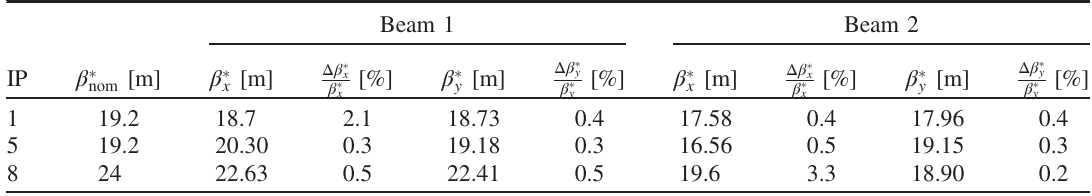
TABLE VII. Measured β (cid:1) and its associated error in IP1, IP5, and IP8 using K mod during the 2016 MD on vdM optics after introducing the IR phase advance as a constraint with Ω ¼ 0 . 2 .